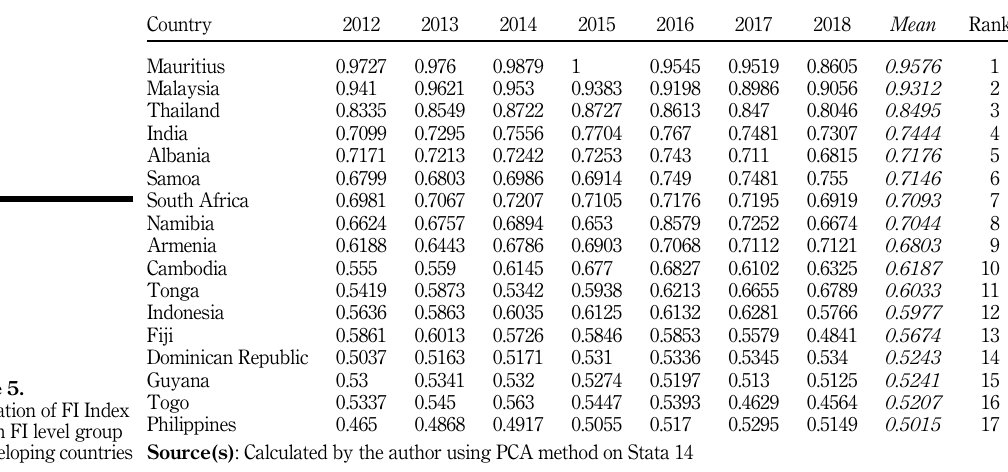
Table 5. Estimation of FI Index of high FI level group in developing